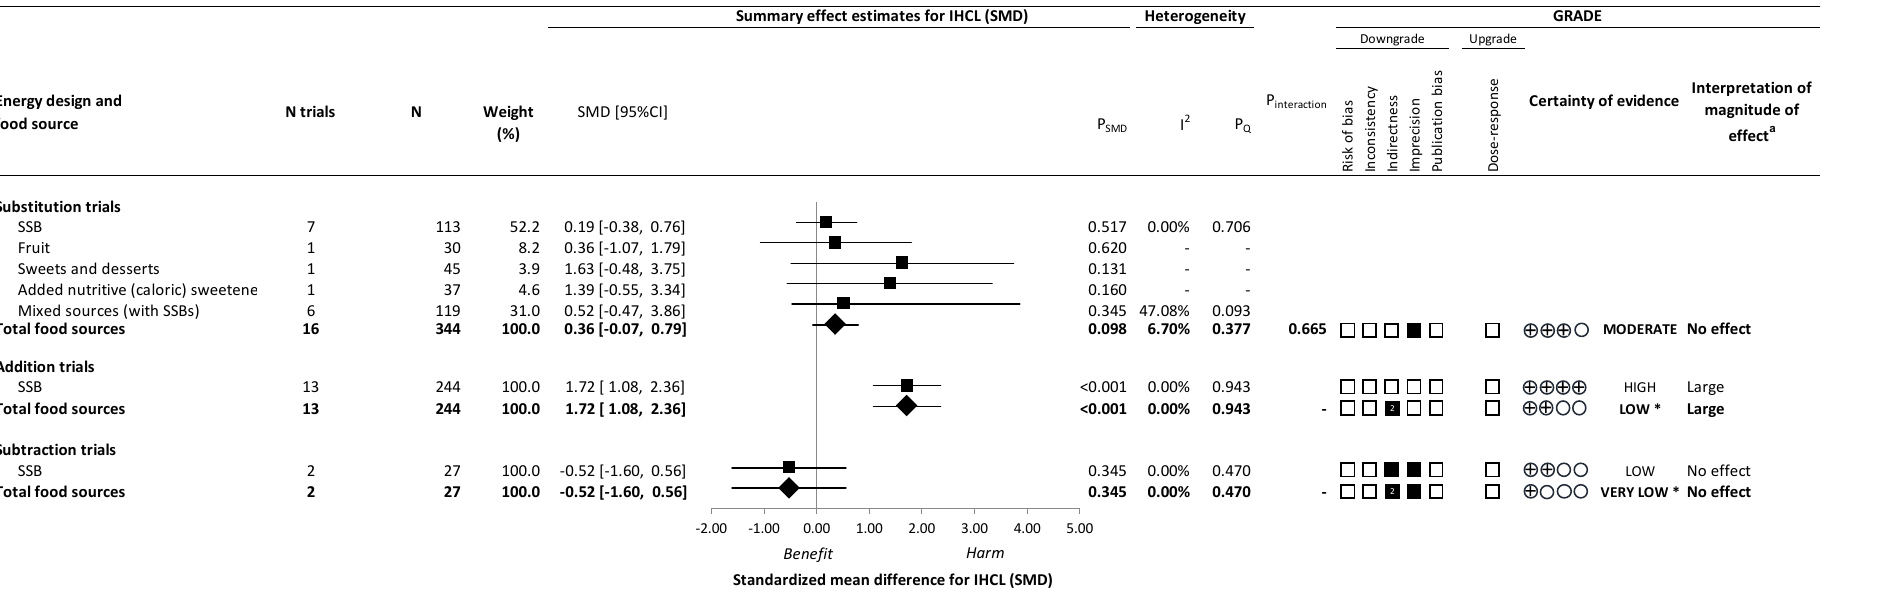
Figure 2. Summary plot for the effect of important food sources of fructose-containing sugars on intrahepatocellular lipid (IHCL). Data are weighted standardized mean differences (95% confidence intervals) for summary effects of individual food sources and total food sources on IHCL. Analyses conducted by generic, inverse variance random effects models (at least five trials available) or fixed effects models (fewer than five trials available). Between-study heterogeneity was assessed by the Cochrane Q statistic, where P Q < 0.100 is considered statistically significant, and quantified by the I 2 statistic, where I 2 ≥ 50% is considered evidence of substantial heterogeneity. The Grading of Recommendations, Assessment, Development and Evaluation (GRADE) of randomized controlled trials are rated as “High” certainty of evidence and can be downgraded by five domains and upgraded by one domain. The white squares represent no downgrades, while filled black squares indicate a single downgrade or upgrades for each outcome, and the black square with a white “2” indicates a double downgrade for each outcome. CI = confidence interval; GRADE = Grading of Recommendations, Assessment, Development and Evaluation; IHCL = intrahepatocellular lipid; N = number; SMD = standardized mean difference; SSB = sugar-sweetened beverage. a For the interpretation of the magnitude, we used the MIDs to assess the importance of magnitude of our point estimate using the effect size categories according to new GRADE guidance. * Where there was a significant interaction by food source in substitution and addition trials and SSBs and mixed sources were the sole food sources in subtraction and ad libitum trials, we performed the GRADE analysis for each individual food source. To convert SMD to % liver fat, multiply the SMD by the baseline pooled standard deviation, 0.71%.